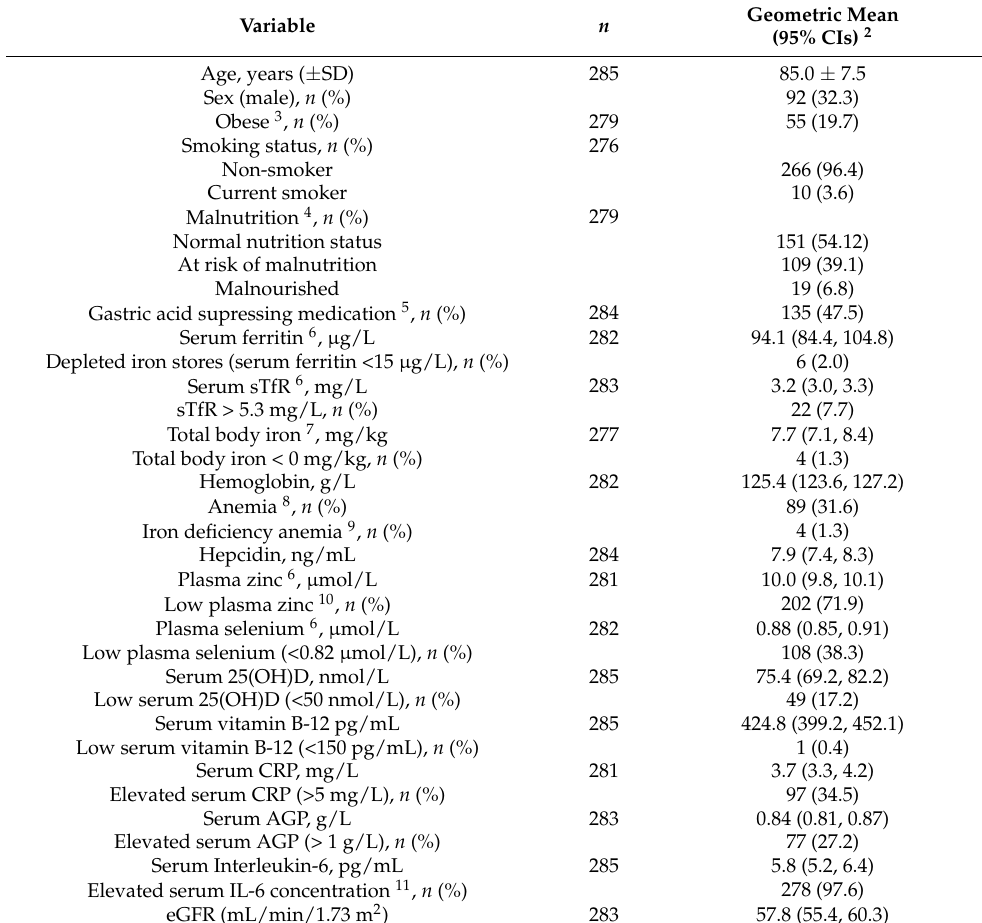
Table 1. Demographic, health, and selected micronutrient data for 285 New Zealand aged care residents 1